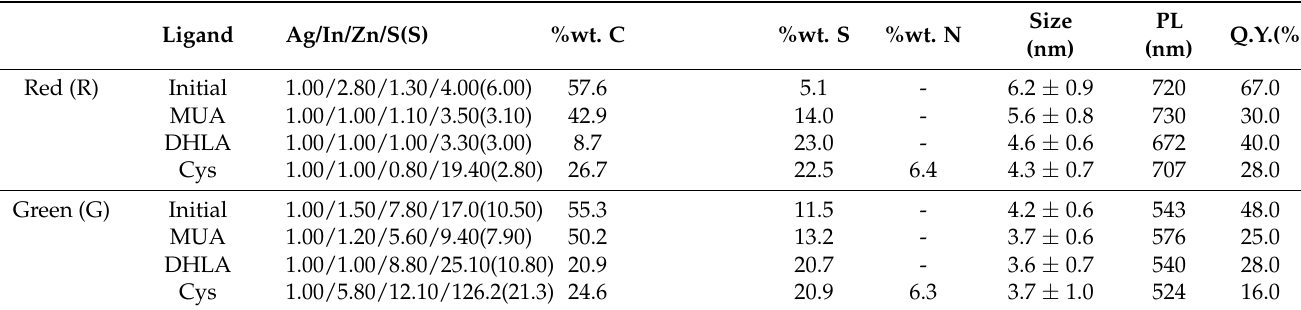
Table 1. Characteristics (composition, size, maximum of the photoluminescence band, and photoluminescence quantum yield (PLQY)) of alloyed AgInS 2 -ZnS nanocrystals before ( R and G ) and after the exchange of initial capping ligands for MUA , DHLA , Cys